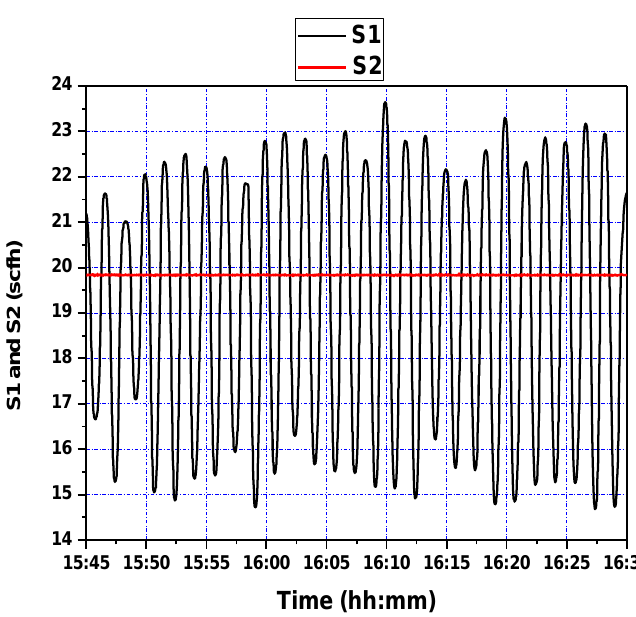
Figure 12. Fluidizing air flow control (S1 and S2) during setpoint changes.